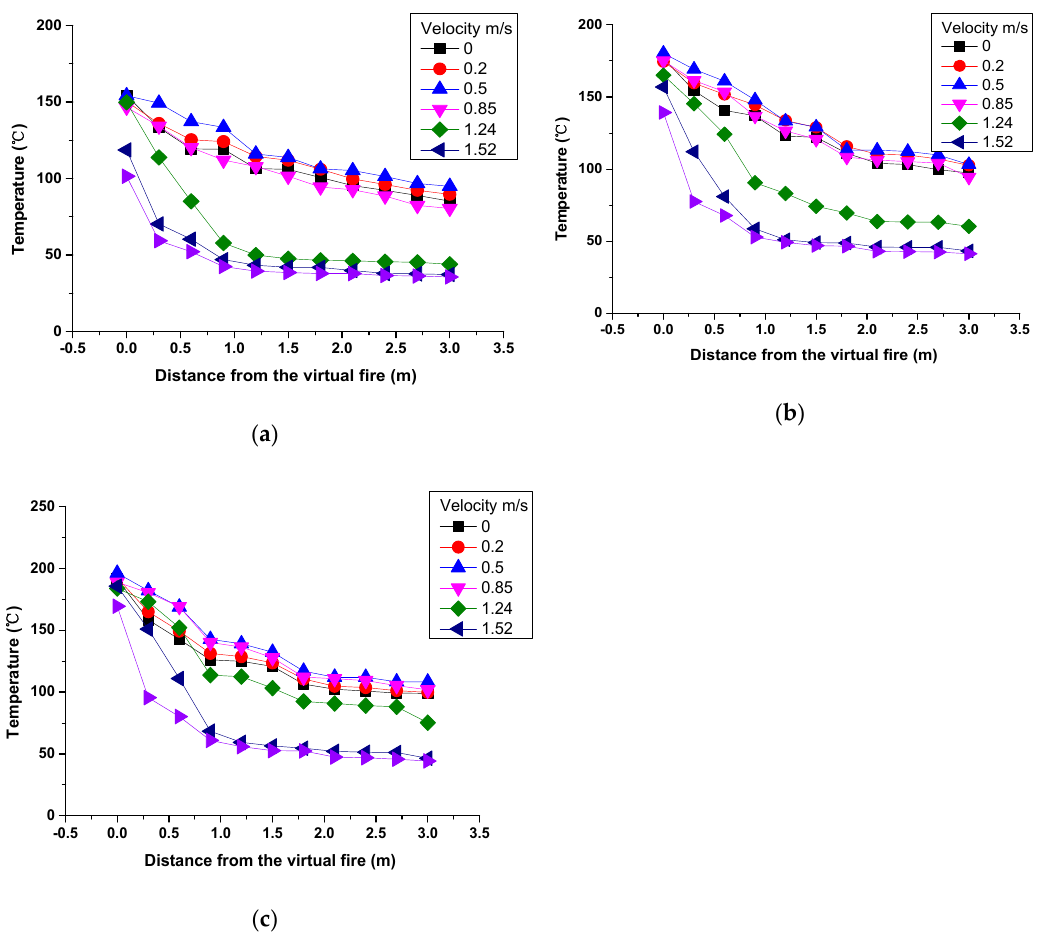
Figure 9. The ceiling temperature distribution for corridor partially open to the environment (with dam-board at the end): ( a ) HRR of 10 kW; ( b ) HRR of 15 kW; ( c ) HRR of 20 kW. In order to study the temperature distribution, the maximum temperature ∆ T max under the ceiling is selected as the reference temperature, and the position where ∆ T max appears is used as the reference point x max because ∆ T max is directly related to the HRR. By using ∆ T max to normalize the temperature increase, the dimensionless temperature increase at different positions under the ceiling is obtained as ∆ T x / ∆ T max . Figure 10 shows the relationship between the non-dimensional temperature increase and the dimensionless distance under the ceiling in the corridor under different wind velocities. It can be seen that when the wind velocity is constant, the non-dimensional temperature